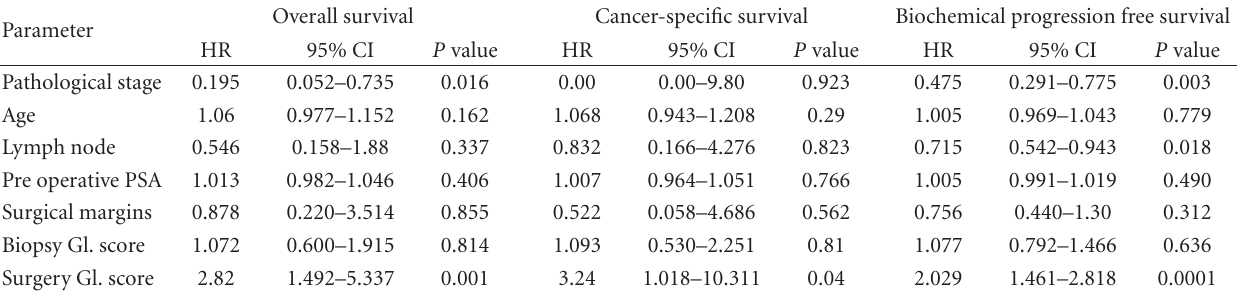
Table 2: Cox multivariate regression analysis of preoperative and histopathologic